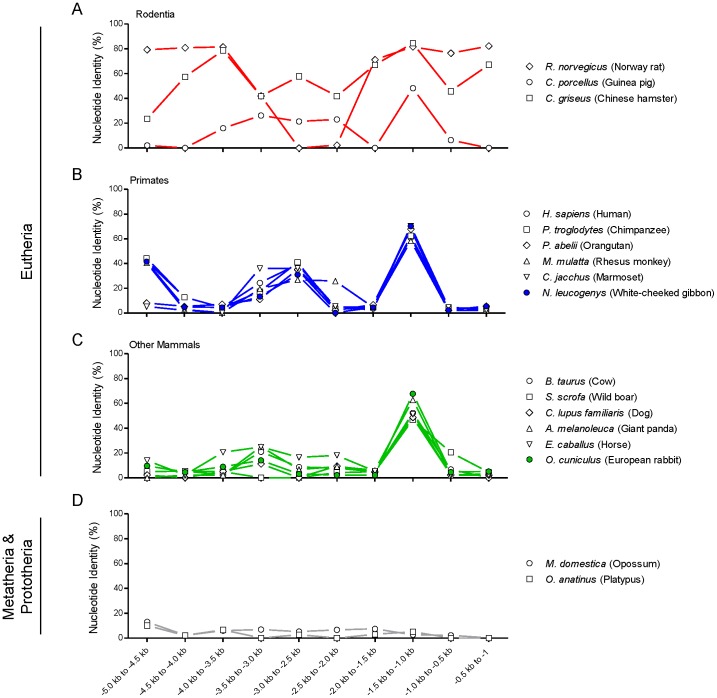
Conservation of the region upstream of Bmp3 between M. musculus and RefSeq mammal genomes.Pairwise alignments were performed between the Bmp3 upstream regions of M. musculus and all seventeen available RefSeq mammalian genomes (15 eutherian, 2 non-eutherian) using BLAST 2.2.26+. Comparing sequential 500 nt sections from M. musculus against the full-length 5 kb region upstream of Bmp3 from the other species allowed for the possibility of genomic insertions or deletions. Findings are separated into taxonomic classification for clarity (A–D). Actual numbers for these analyses are listed in Table S3. Conservation with R. norvegicus, H. sapiens, and B. taurus are based upon the primary assembly.